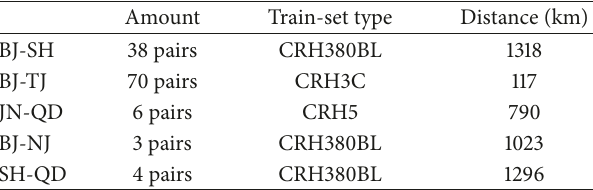
Table 3: Trips between different